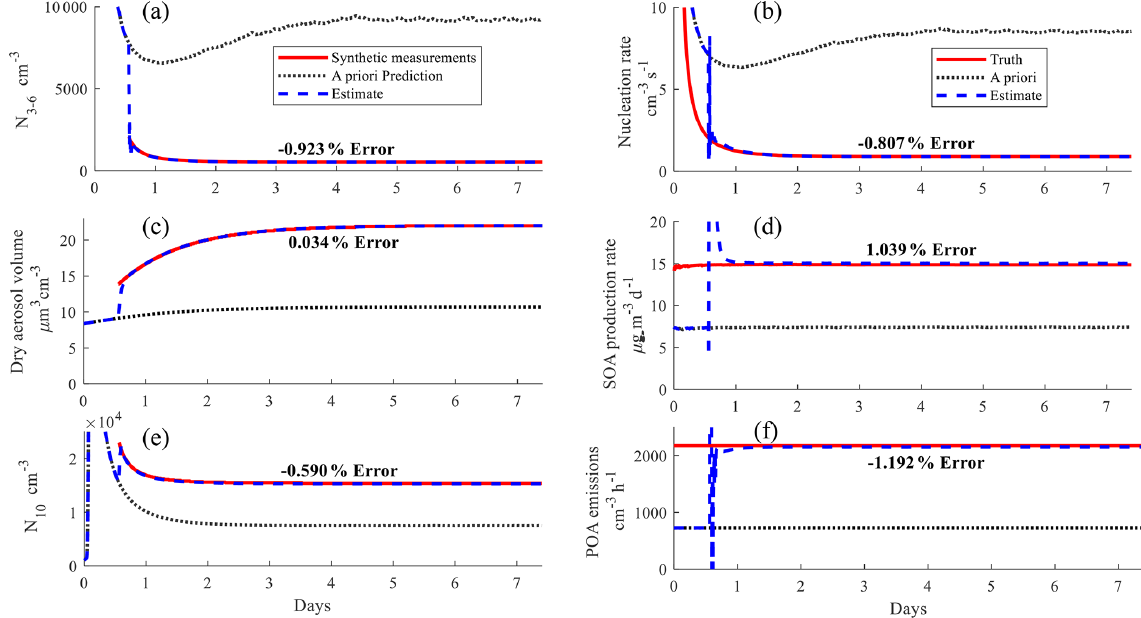
Figure 2. Estimated, measured, and a priori inventory variables are in the left panels, and estimated, true, and a priori process rates are in the right panels for scenario no. 26 of the proof-of-concept scenarios. The measurements are (a) N 3–6 , (c) V dry , and (e) N 10 . The process rates are (b) nucleation rate, (d) SOA production rate, and (f) POA emission rate.